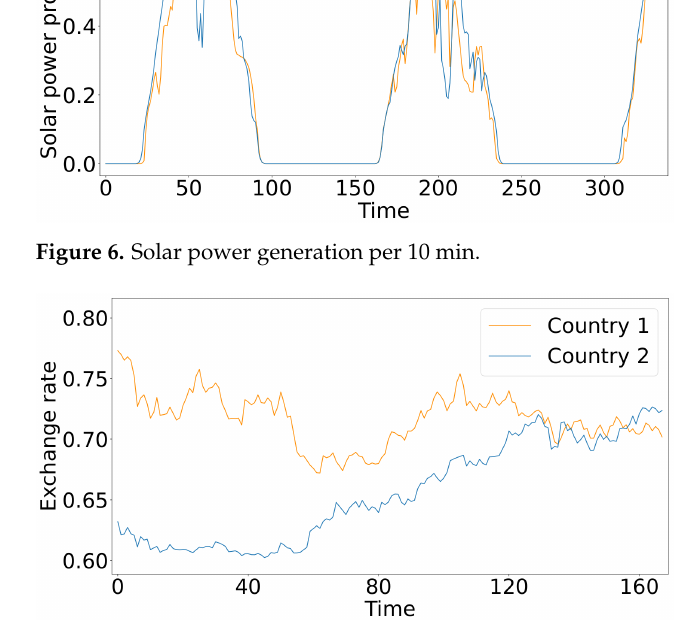
Figure 7. Daily exchange rates for two